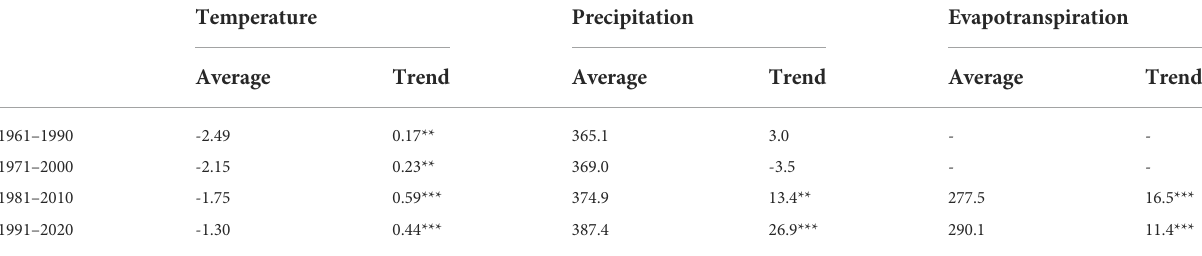
TABLE 1 The average values and trend rates (per decade) of temperature ( ° C), precipitation (mm), and actual evapotranspiration (mm) in different periods of the Tibetan